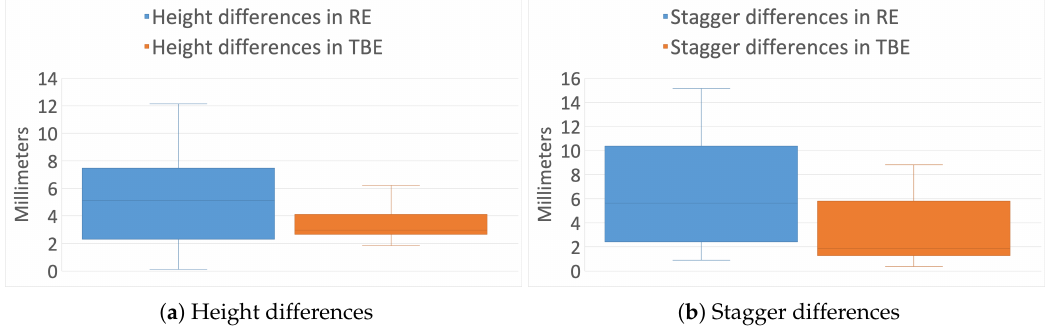
Figure 15. Height and stagger differences’ distribution in real and test bench